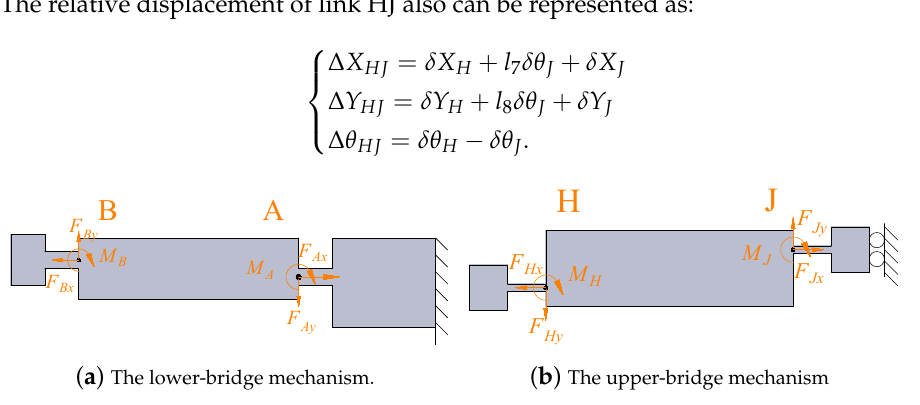
Figure 6. Static body analysis of the